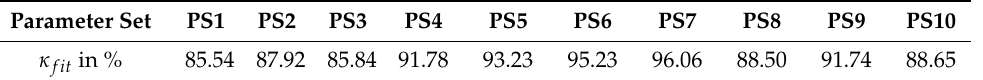
Table 3. Consistency of the model prediction with the actual measurement